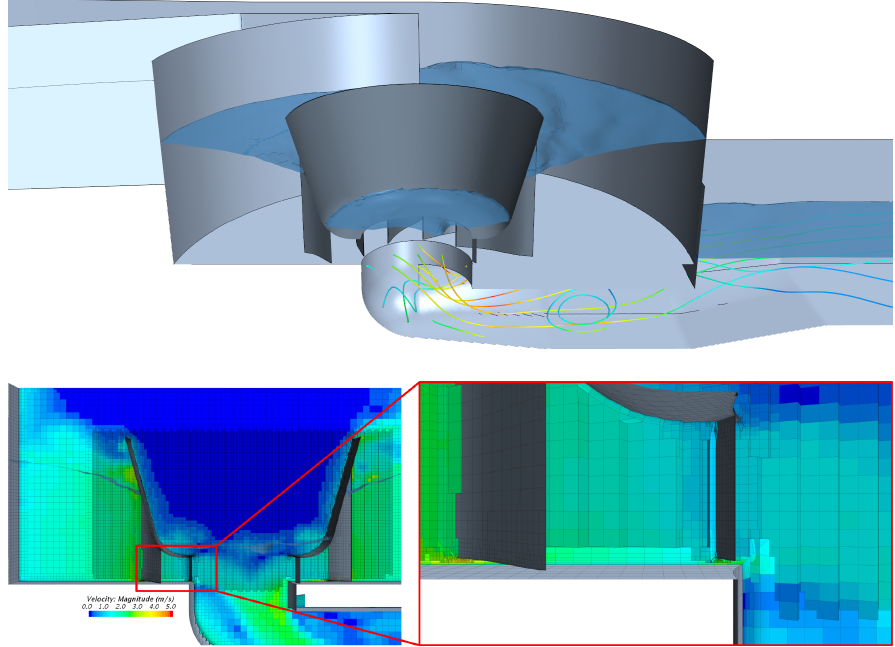
Figure 3. Views from complete simulations of the flow in the WVPP . Top: the device has been sectioned longitudinally so as to display the water level and turbine position in the WVPP . A few streamlines colored according to velocity are visible in the outlet of the turbine. Bottom: view of the mesh structure in the turbine basin, colored according to velocity. Full details of this simulation are published in Powalla et al. 2021